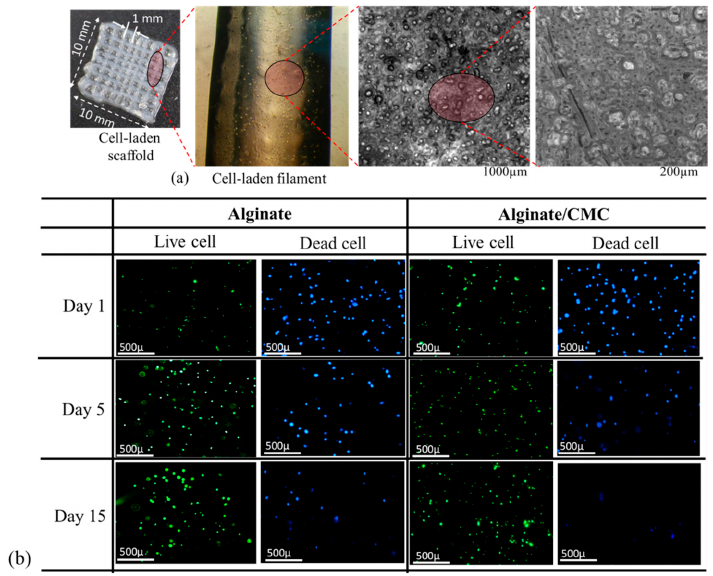
Figure 20. ( a ) Cell-laden scaffold and filament and ( b ) Live/dead staining of BxPC3 cell encapsulated in alginate and Alg-CMC hydrogel at different time periods.